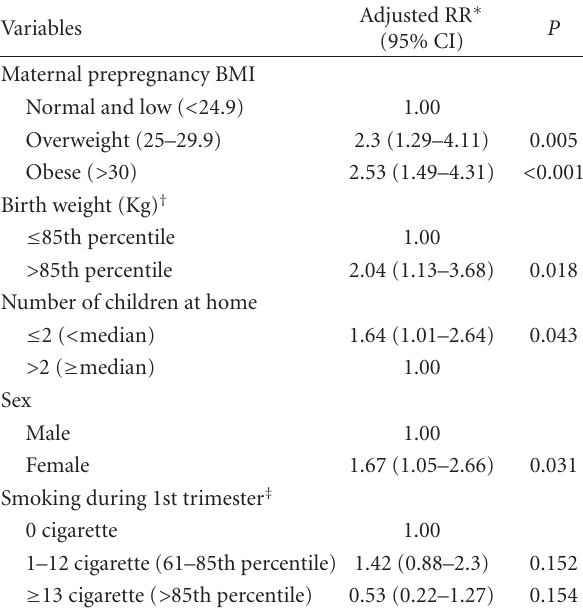
CI: confidence interval. ∗ Adjusted risk ratio computed using poisson regression model with robust variance estimation. † Based on gestational age and race specific birth weight percentiles for US population. ‡ Cigarettes smoked per day.